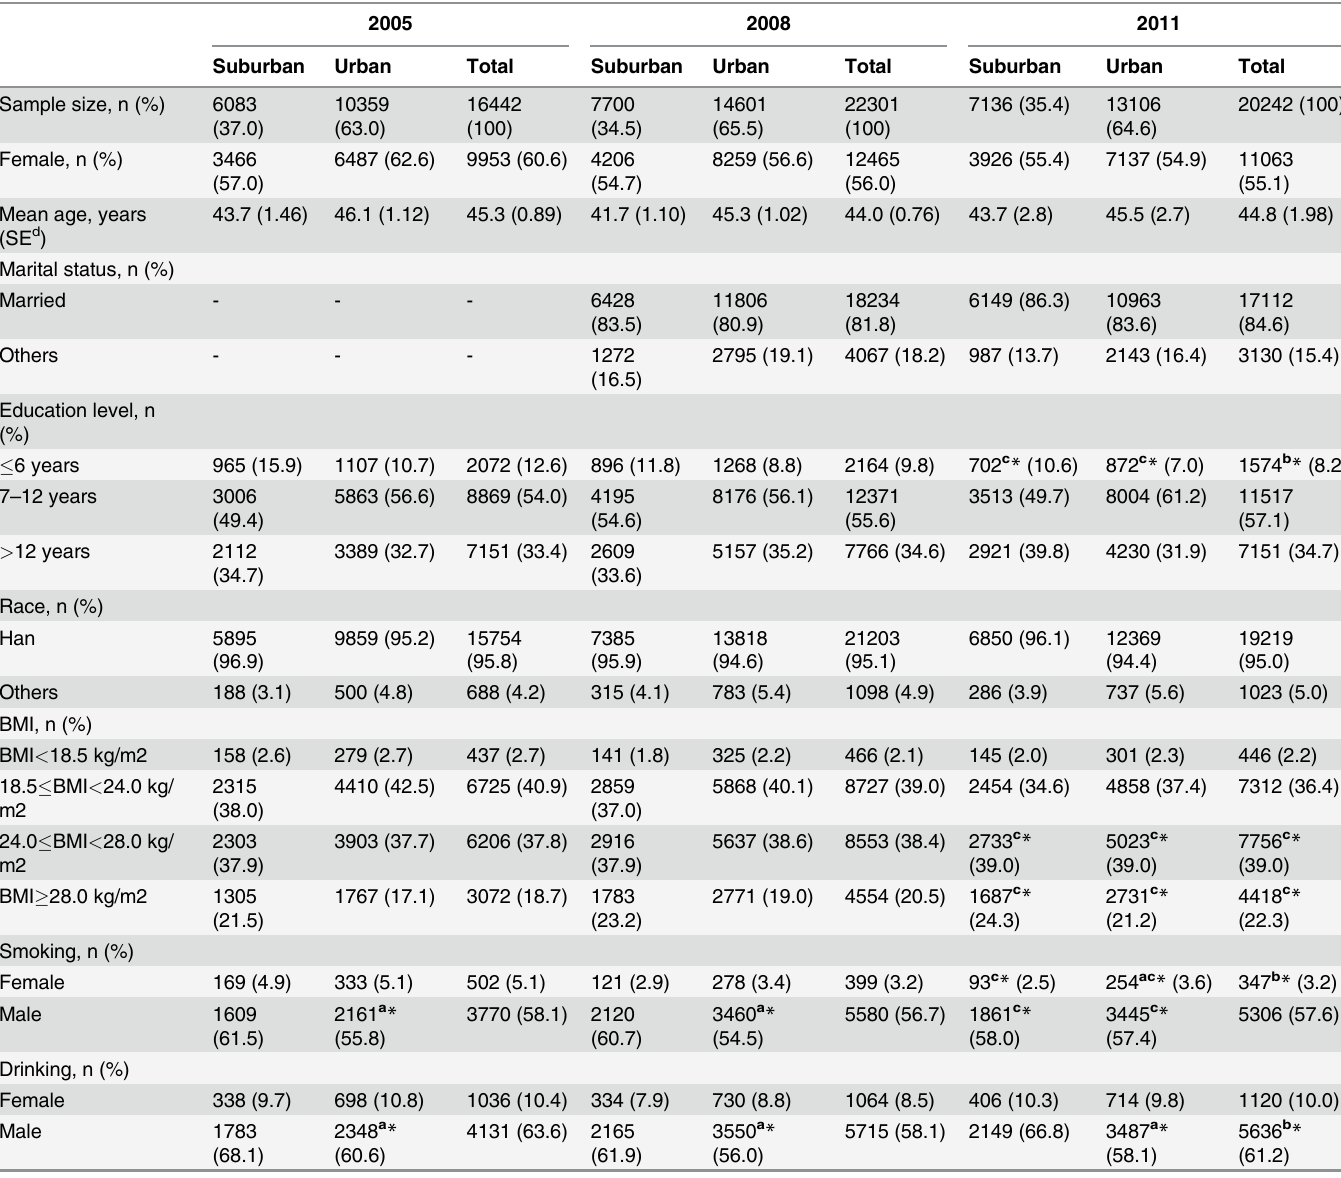
Table 1. Characteristics of study participants in Beijing from 2005 to 2011. 2005 2008